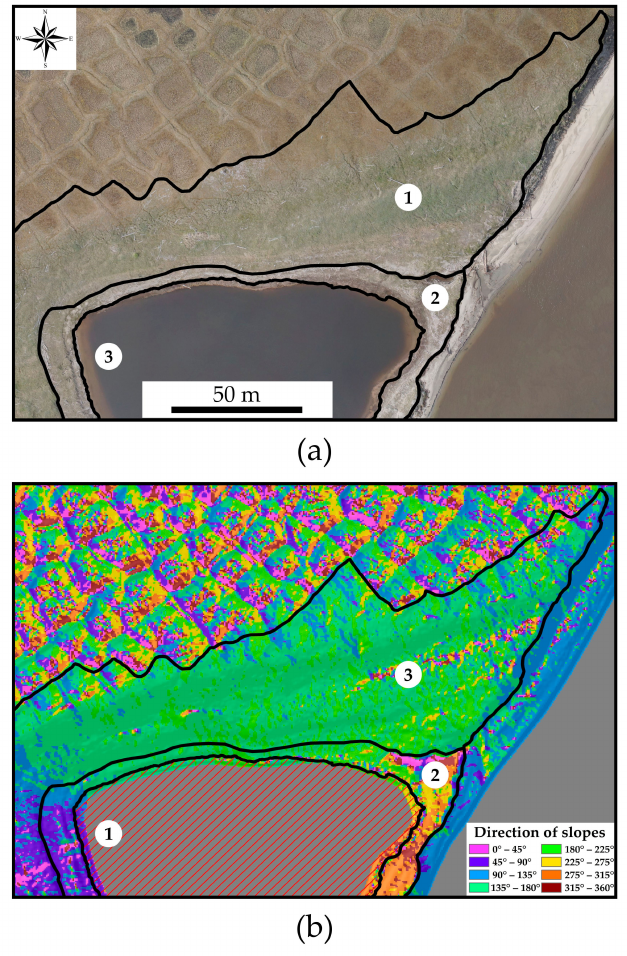
Figure 8. Lakes and other water bodies (number 1 in a white circle), valleys (2), and slopes (3) in ( a ) an orthophoto map that is mixed with a GSR map, and in ( b ) an aspect